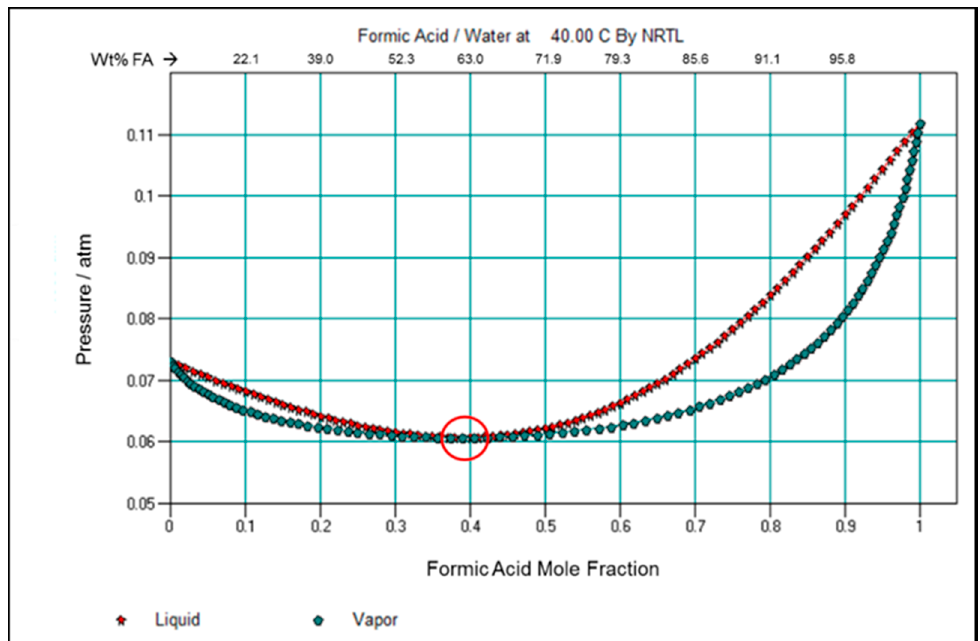
Figure 9. Formic acid-water vapor Txy equilibrium plot at a constant temperature of 40 °C generated using ChemCad-generated data using the non-random two-liquid (NRTL) model in generating the simulation data. The circle shows the pressure-minimum azeotrope composition.